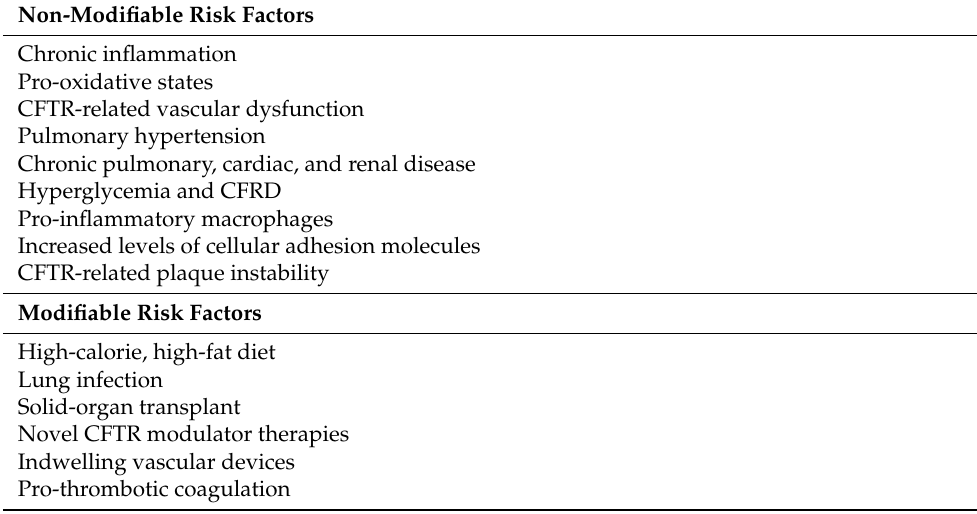
Table 2. Potential cardiovascular risk factors in people with cystic fibrosis